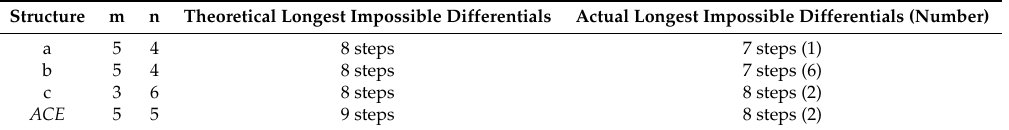
Table 2. Properties of